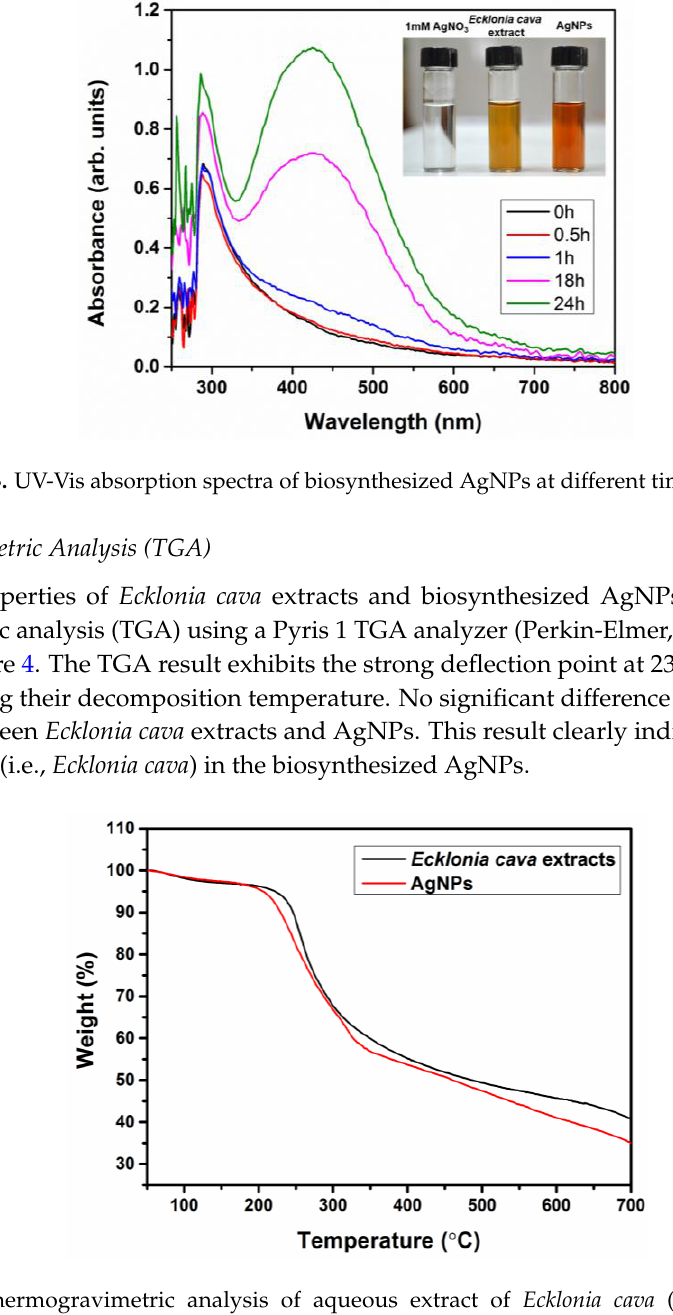
Figure 4. Thermogravimetric analysis of aqueous extract of Ecklonia cava (black curve) and biosynthesized AgNPs (red curve).